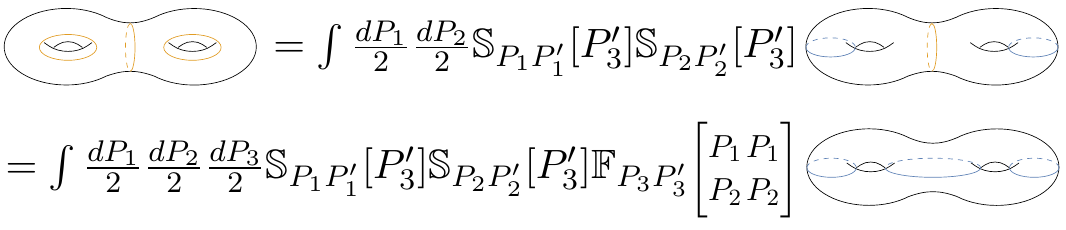
Figure 7 . The sequence of moves expressing a genus 2 ‘dumbell’ channel block in terms of ‘sunset’ channel